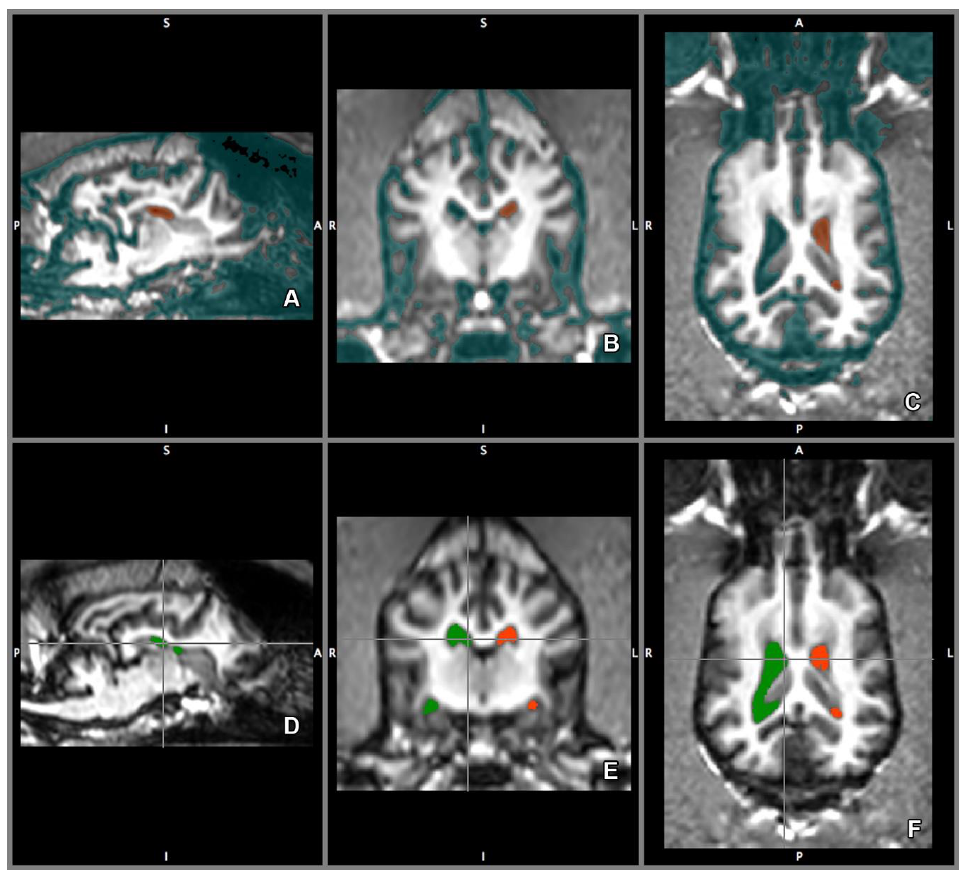
Figure 4. Lateral ventricle template. Based on the CSF segmentation template, the left ventricle is delineated (red area, A – C ), and left (red area) and right (green area) ventricles delineated ( D – F ) using 3-dimensional tracing. The lateral ventricles are traced separately, creating a template for each of them, the volume of the templates then were calculated. Directions are referred as superior (S), inferior (I), posterior (P), anterior (A), left (L) and right (R).